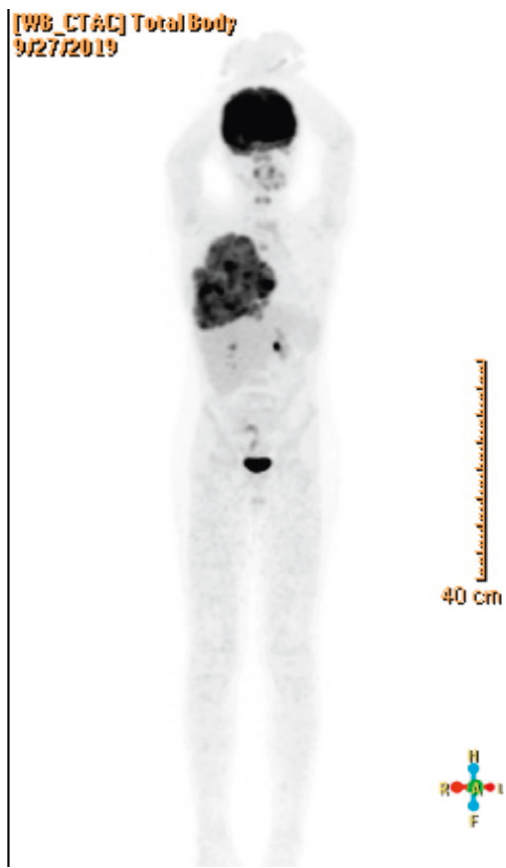
Figure 2: A PETscan performed at the initial encounter. The PET scan obtained before starting treatment showed a large soft tissue mass occupying the right hemithorax, invading the anterior chest wall and the overlying ribs, consistent with the known Ewing sarcoma. There was no evidence of FDG-avid disease in the rest of the